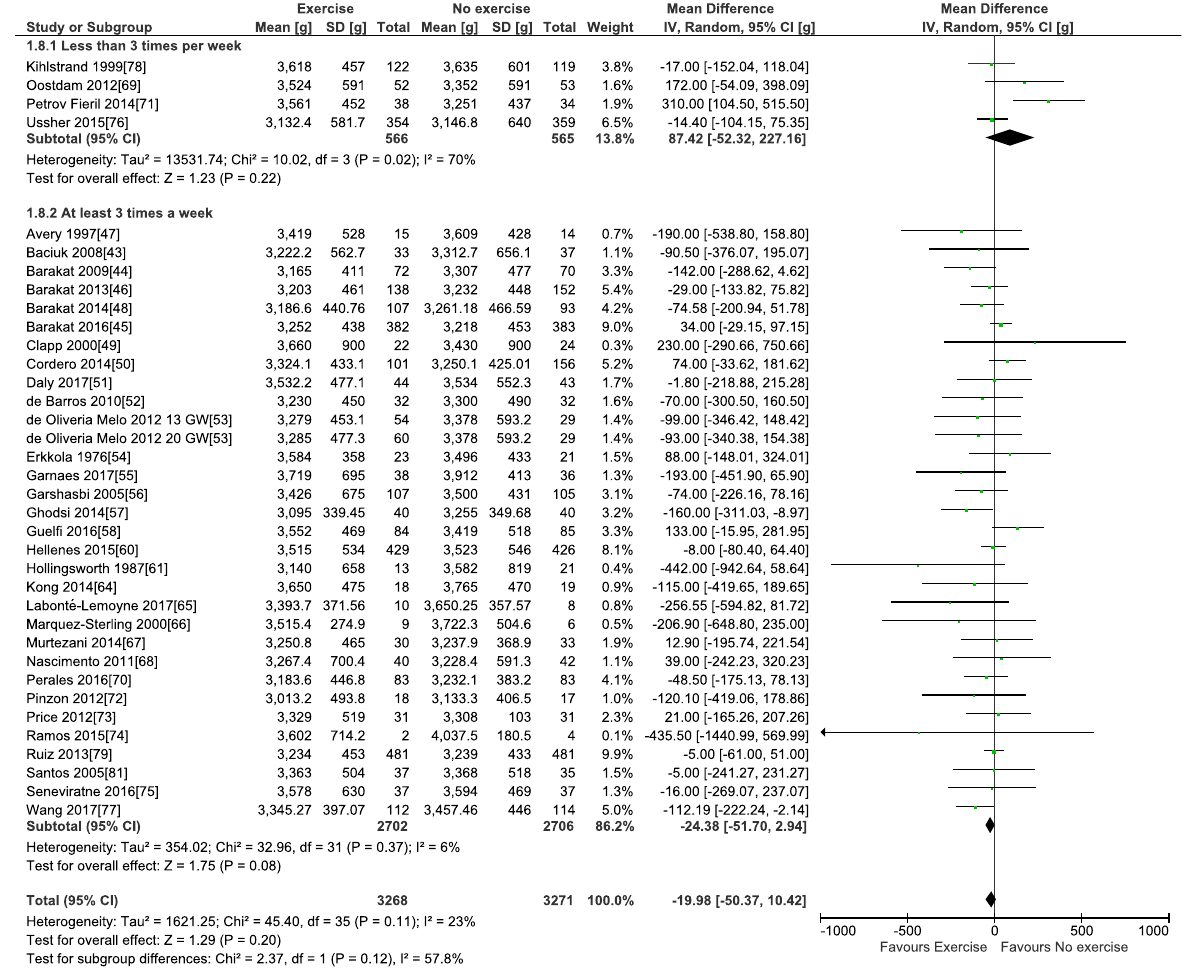
Fig. 7 Forest plot of pooled mean differences for birthweight after exposure to prenatal exercise vs. no exercise; sub-grouping by frequency of the exercise: Less than 3 times per week, and At least 3 times per week